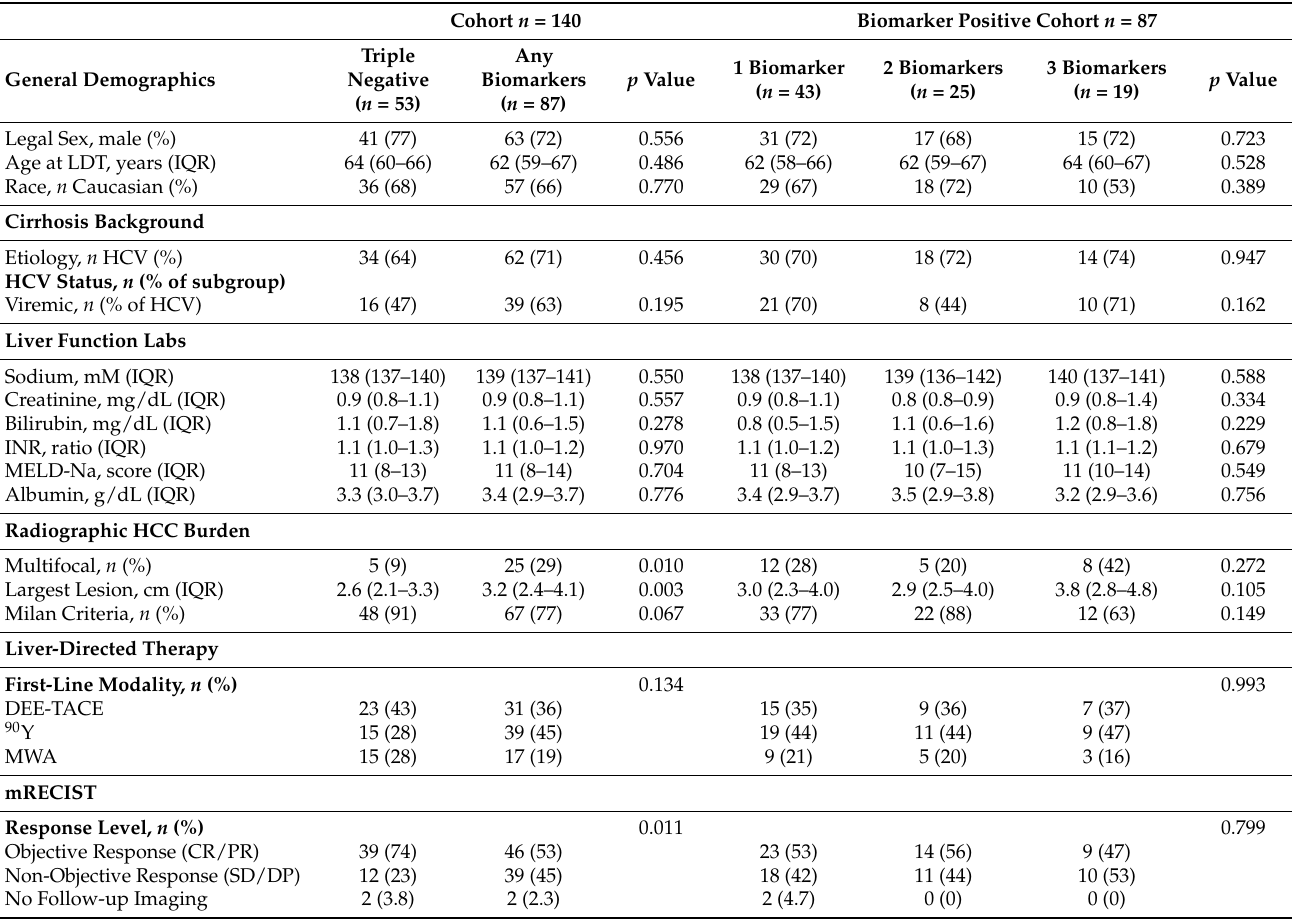
Table 4. Baseline Factors Stratified by Biomarker